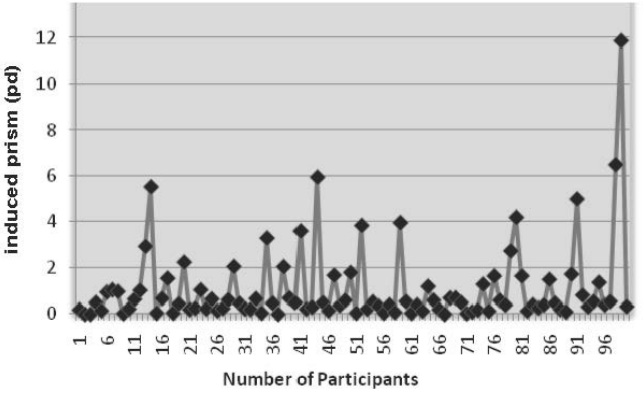
Figure 4: showing the ranges of the induced vertical prismatic effects experienced by participants (ANSI = 0.25